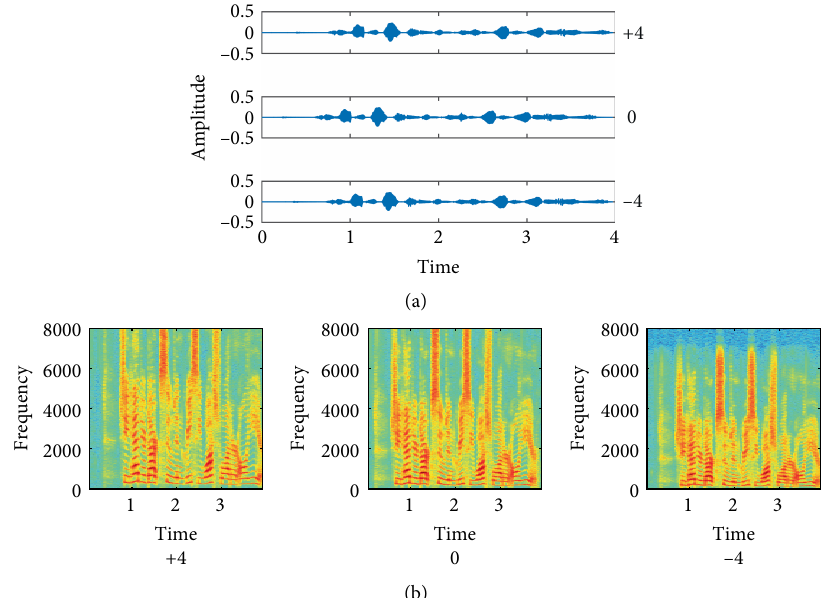
Figure 1: Waveform and spectrogram of original voice and pitch-shifted voice. (a) Waveform; (b) Spectrogram.